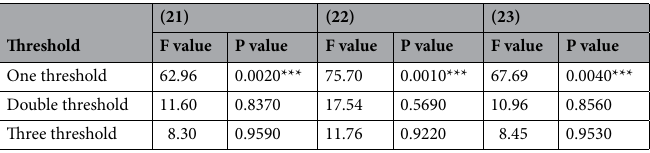
Table 8. Threshold effect test results. * p < 0.1, ** p < 0.05, *** p < 0.01; the bracket represents the t value.